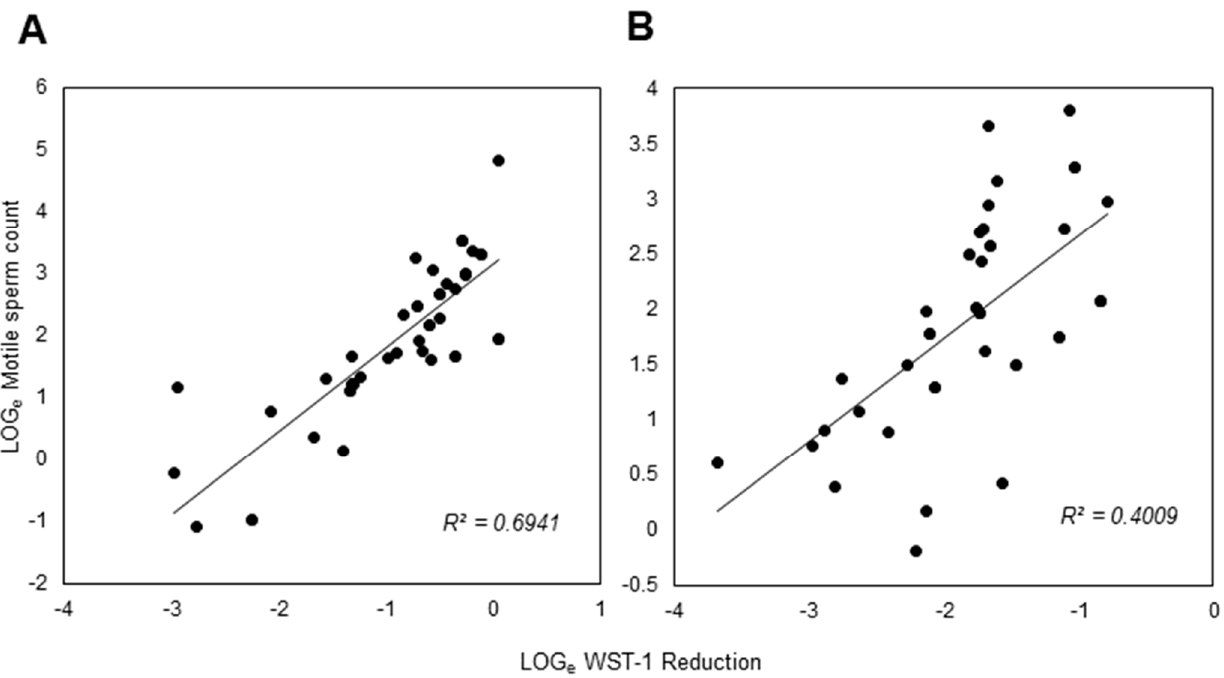
Figure 3. WST-1 reduction by stallion spermatozoa isolated in a Samson™ chamber. WST-1 reduction by cells isolated both ( A ) prior to chilling and ( B ) post-chilling were significantly correlated with the total number of motile cells ( p < 0.001).